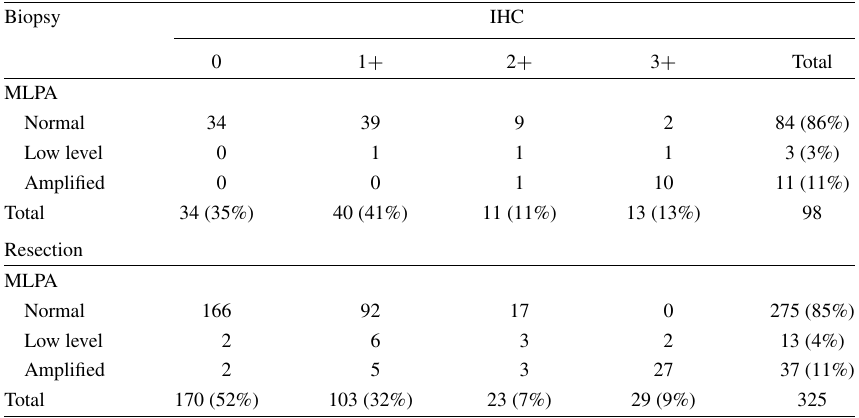
Comparison of the HER-2/ neu protein overexpression by immunohistochemistry (IHC) with gene amplifi- cation by multiplex ligation-dependent probe amplification (MLPA) in biopsies and resections separately Biopsy